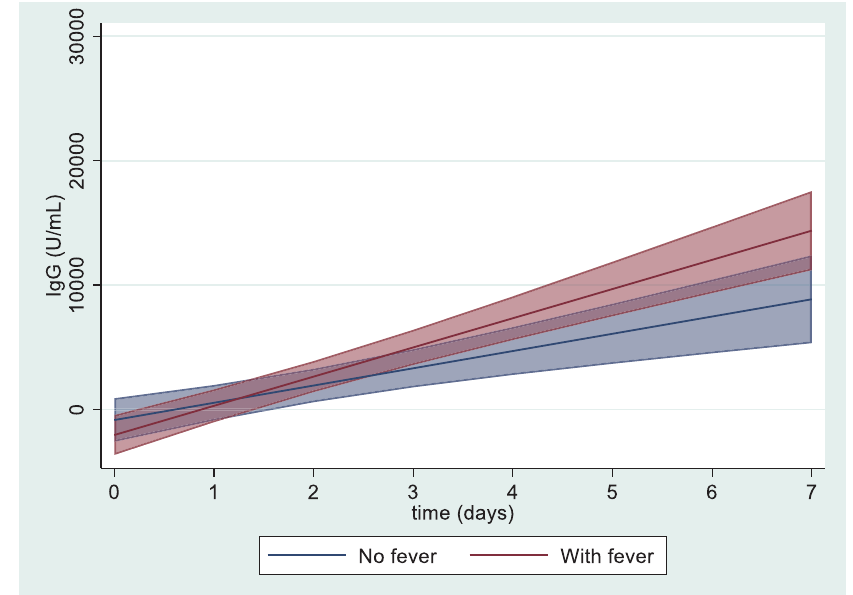
Figure 1. Immunoglobulin G (IgG) dynamics in the fi rst week after vaccination by presence or absence of post-vaccination fever. The red and blue lines show the IgG concentration means predicted by the mixed-e ff ects model in the febrile and nonfebrile groups, respectively. The area of each color indicates the 95% con fi dence interval (CI) of the regression curve. Day 0 is a negative value owing to the e ff ect of the modeling